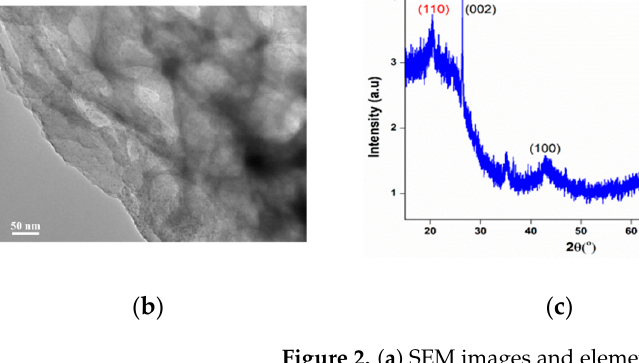
Figure 2. ( a ) SEM images and elements mapping of C, O, and F ( 1 – 4 ) and full EDX spectra ( 5 ) of the CS’s cathode. ( b ) TEM image of the CS’s cathode. ( c ) XPS survey spectra—full spectrum of the CS’s cathode. The red-labeling of the peak indicates that it is from PVDF, while black indicates that it is from activated carbon and carbon black. ( d ) CV plots of the CS sensor anode with and without biofilm grown, respectively (scan rate of 10 mV/s).